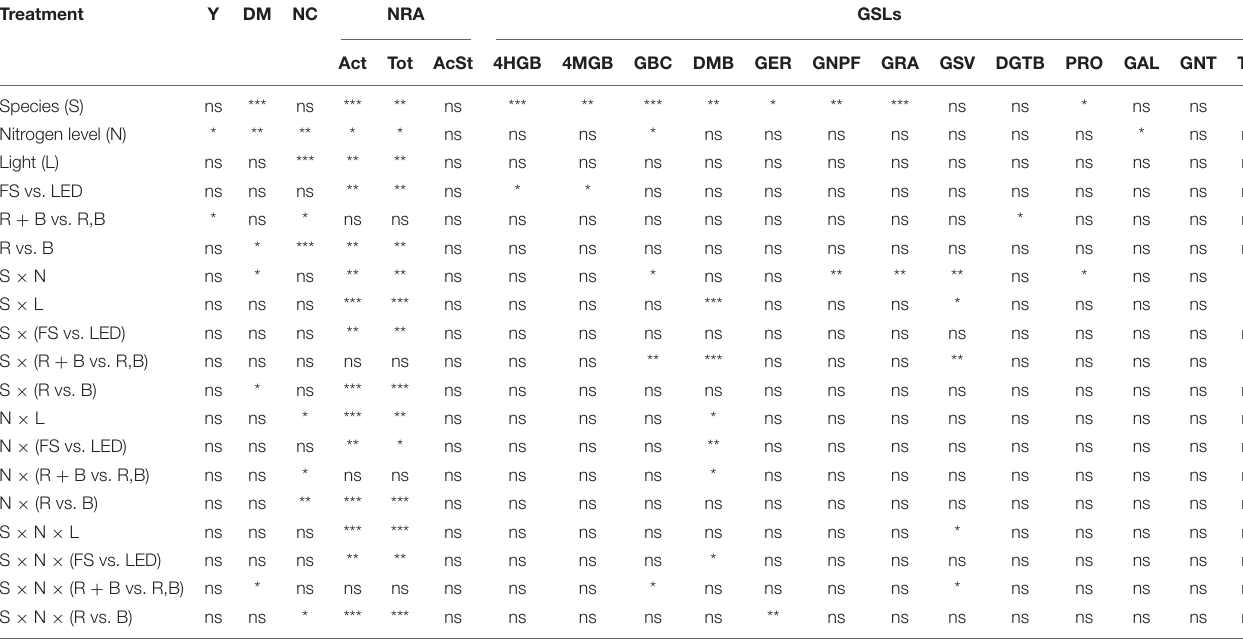
TABLE 2 | Summary table of variance of the main treatments and interactions. Treatment